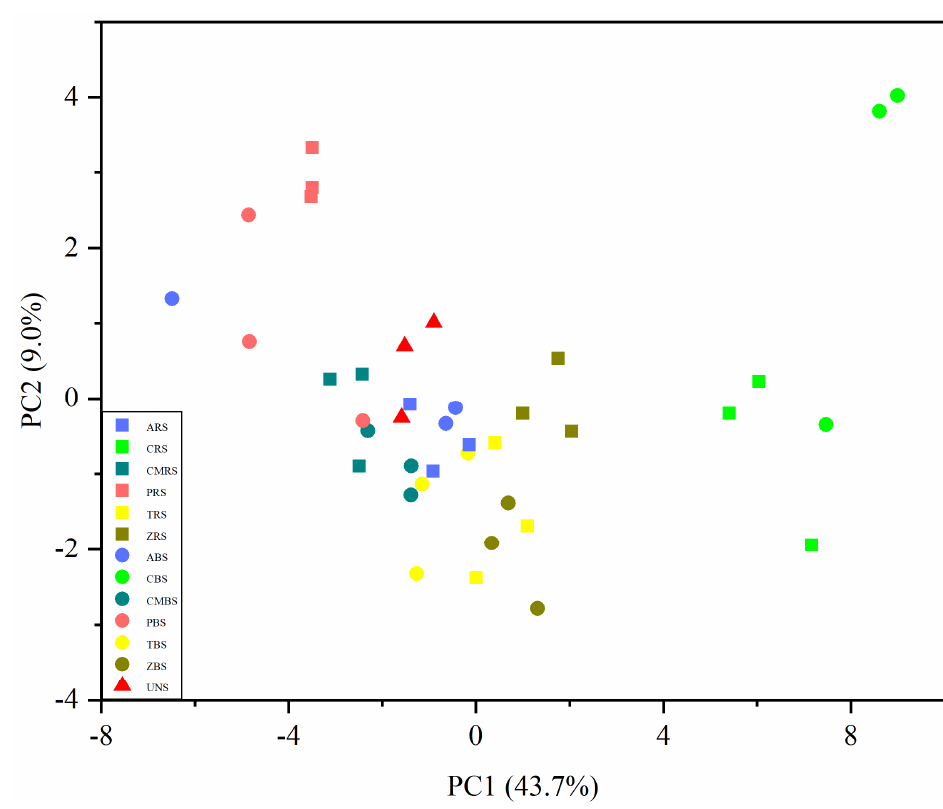
Figure 3. Principal component analysis of microbial carbon utilization patterns using Biolog™ EcoPlates from rhizosphere and bulk soils from six native plants and uncontaminated soil. Squares represent rhizosphere soil; circles represent bulk soil; triangles represent uncontaminated soil. For abbreviations see Table 1.